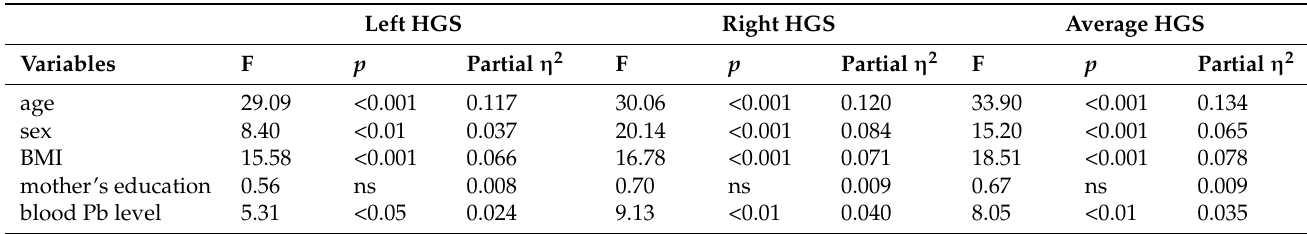
Table 2. Results of analysis of covariance for left HGS, right HGS and average HGS as dependent variables and blood level group (below or equal and above the median value = 3.10 µ g/dL),